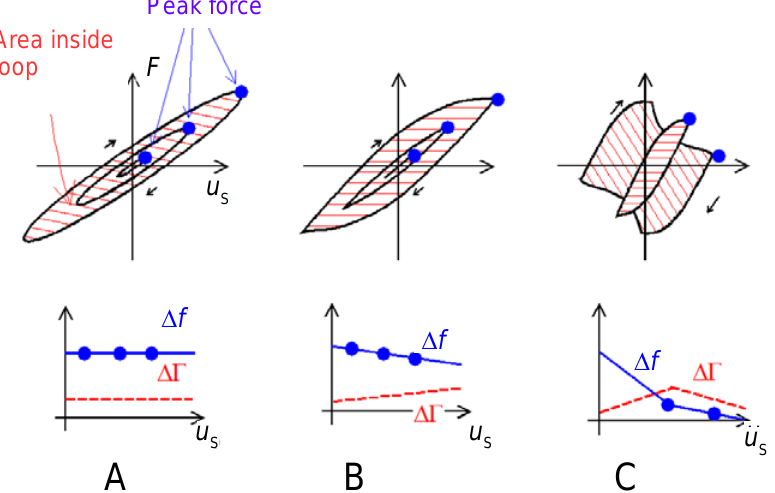
Figure 28. The top panels show friction loops for three different contacts. ∆Γ is strictly proportional to the area inside the loop, divided by u 2 . ∆ f is nearly proportional to the maximum force divided by the maximum displacement (blue dots). The left-hand side ( A ) shows the linear viscoelastic contact. ∆ f and ∆Γ are constant. For partial slip ( B ) the ellipse-shaped loop turns into a lens-shaped loop. The area inside the loop increases with amplitude as u 3 and ∆Γ increases with amplitude, in consequence. The sketch in ( B ) is based on a quantitative model. The right-hand side ( C ) sketches the transition to gross slip. The diagram is motivated by experimental results [141], not by a quantitative model. ∆Γ decreases at large amplitude because the friction force in steady sliding weakly depends on velocity. Dividing by u 2 causes ∆Γ to decrease with u S